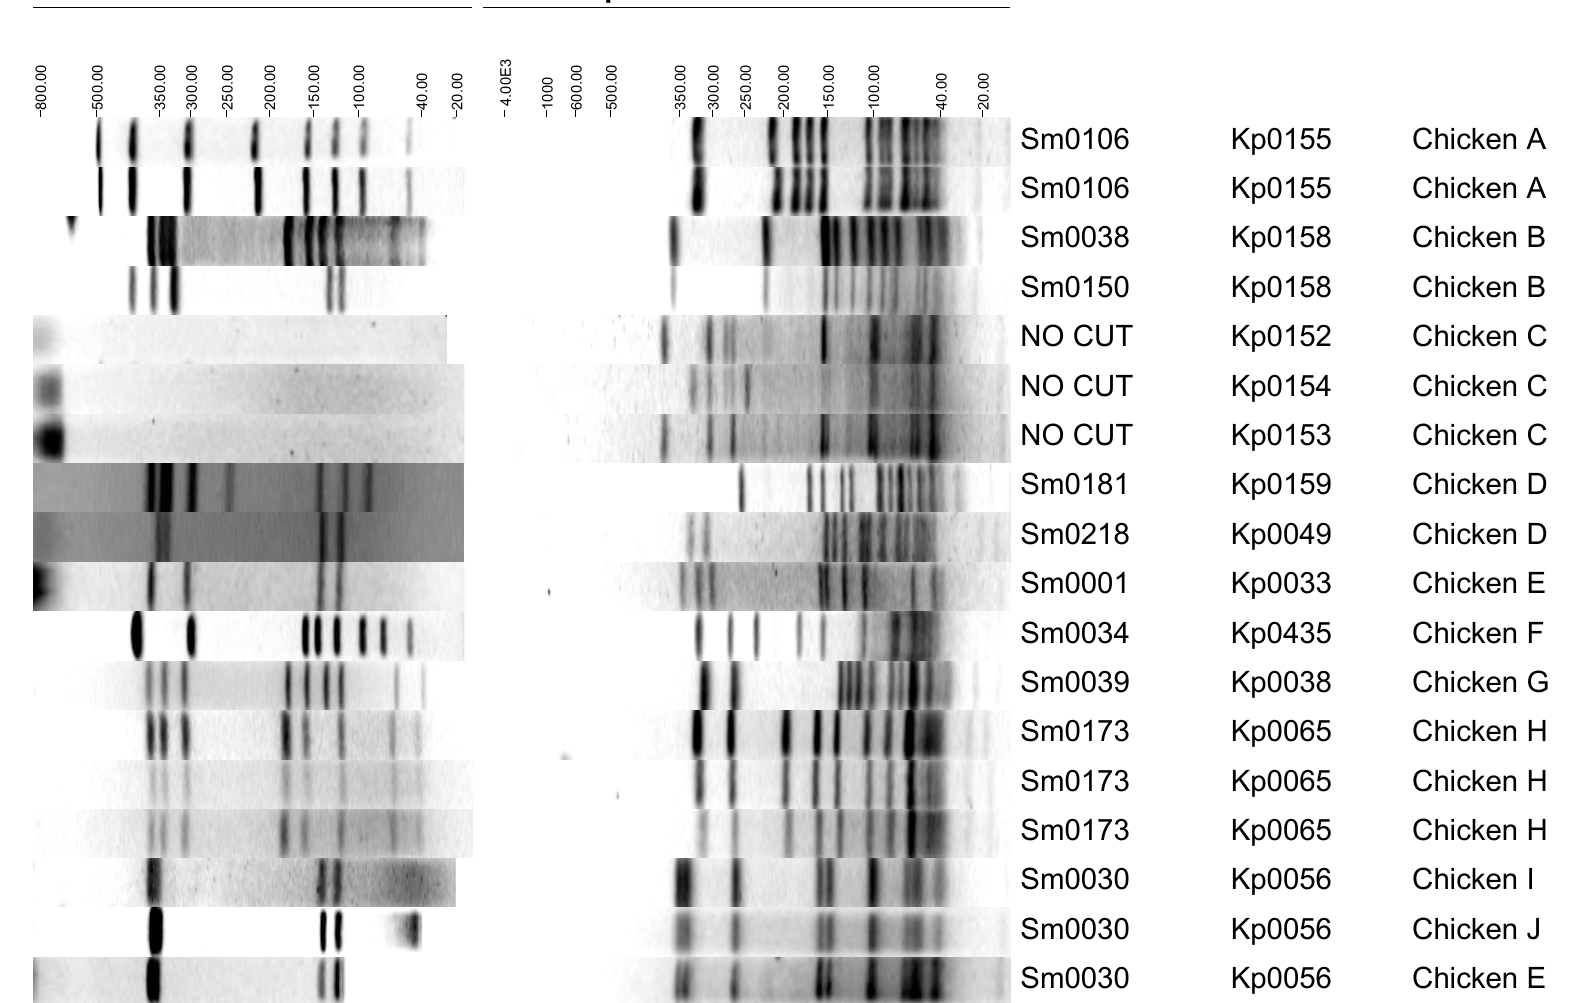
Figure 1. Pulsed-field gel electrophoresis (PFGE) profiles of Campylobacter jejuni representing all chicken carcass isolates.